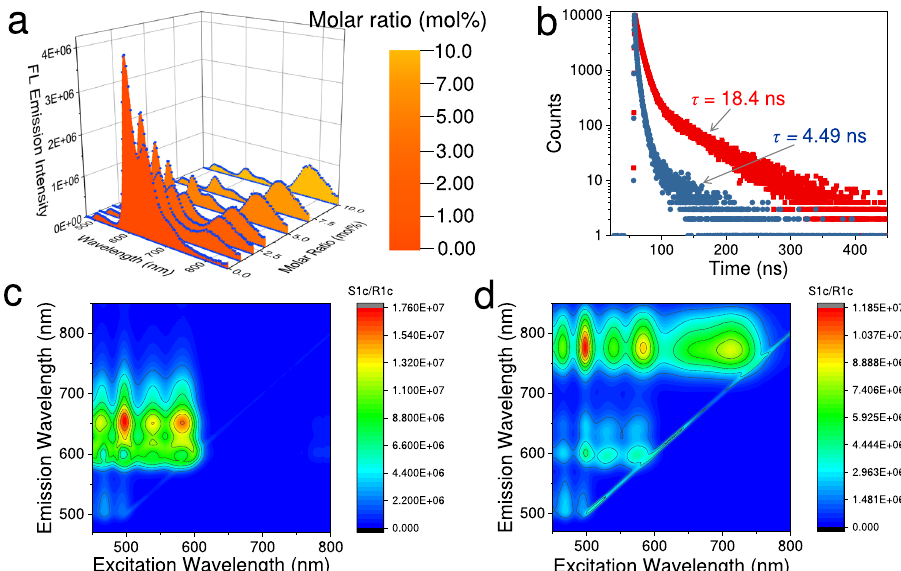
Fig. 5 Sequential energy transfer behaviors of the ternary supramolecular copolymers 1/2/3. a Steady-state fl uorescence emission changes upon titrating 3 into supramolecular copolymers 1 / 2 (100: 20 mol%) ( c : 8.0 × 10 − 5 mol L − 1 for 1 and 1.6 × 10 − 5 mol L − 1 for 2 in MCH). The fi lling colors of emission pro fi les are de fi ned according to the Commission Internationale de l ’ Eclairage (CIE) coordinates. b Fluorescence lifetime decay curves of supramolecular copolymers 1 / 2 (100: 20 mol%) and 1 / 2 / 3 (100: 20: 10 mol%) at 599 nm (c: 8.0 × 10 − 5 mol L − 1 for 1 , 1.6 × 10 − 5 mol L − 1 for 2 , and 8.0 × 10 − 6 mol L − 1 for 3 in MCH). c Two-dimensional excitation spectrum of the binary supramolecular copolymers 1 / 2 . d Two-dimensional excitation spectrum of the ternary supramolecular copolymers 1 / 2/3 .